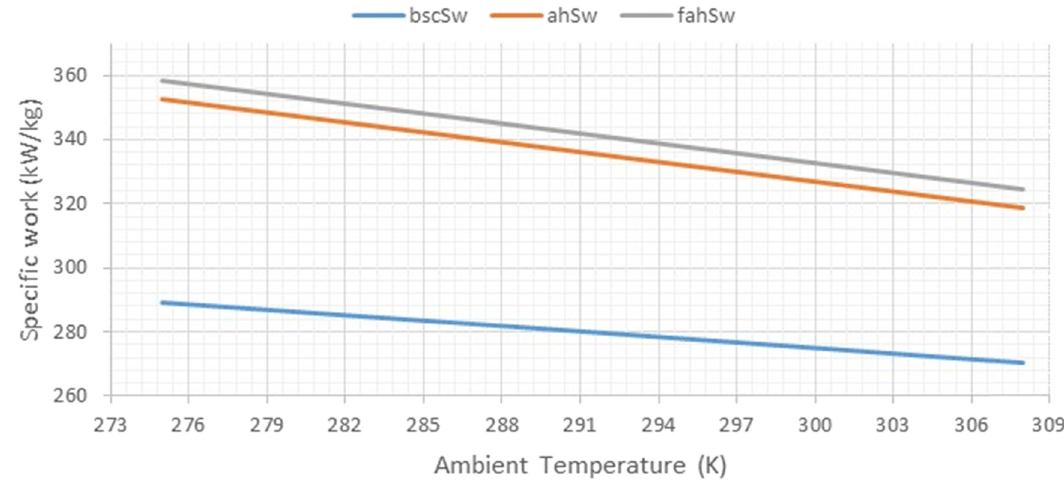
Figure 10: Variation of the speci fi c work with ambient temperature for bsc, ah and fah cogeneration